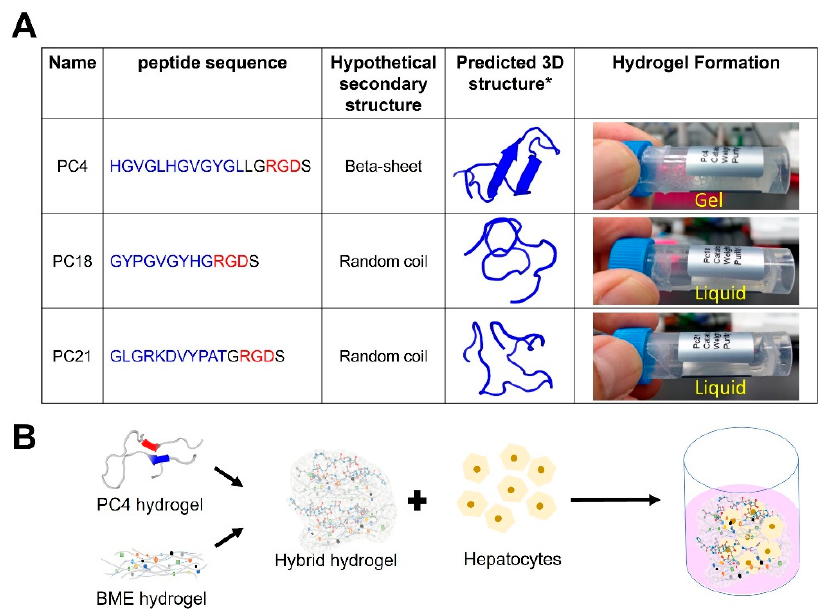
Figure 1. Design and generation of PC4/Cultrex hybrid hydrogel. ( A ) Peptide sequences inspired by the repetitive motif of sandcastle worm adhesive protein (highlighted in blue color). The cell adhesion motif RGD was highlighted in red. * Predicted secondary structure of the peptides using PEP-FOLD 3.5 method. ( B ) The schematic diagram showed the experimental design of hepatocytes encapsulated in the PC4/Cultrex hybrid hydrogel.